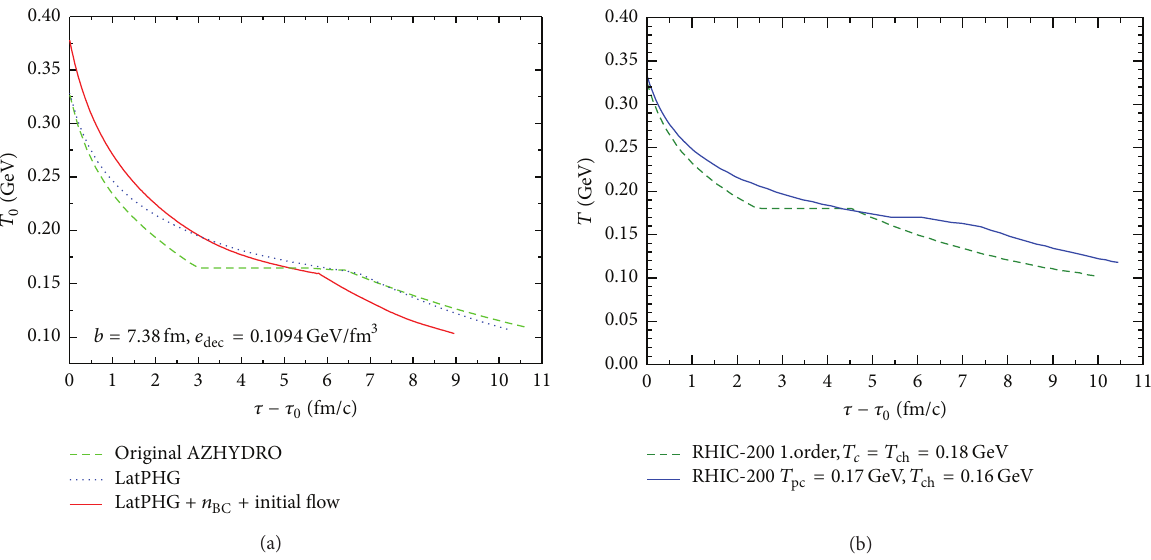
Figure 4: Time evolution of fireball temperature in semicentral Au-Au (√𝑠 = 0.2 GeV ) collisions at RHIC within (the central cell of) ideal hydrodynamics (a) [42] and an expanding fireball model (b). The dashed green and dotted blue lines in (a) are to be compared to the dashed green and solid blue lines in (b),